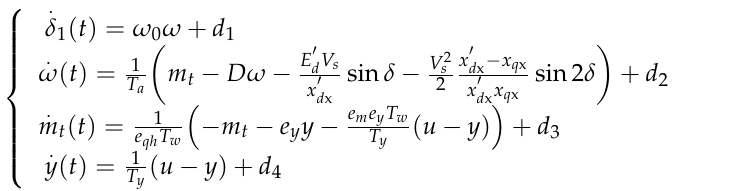
Figure 2. Lyapunov exponents of system (1). Using the same parameters as above, a bifurcation diagram of the system with the variation of 𝛿 1 (𝑡 0 ) is shown in Figure 3a, and the mean value of 𝛿 1 is given in Figure 3b. Here, 𝛿 1 (𝑡 0 ) varies from −5 00 to 500 with a step size of four. It is shown in Figure 3 that the value of variable δ1 increases with the increase of 𝛿 1 (𝑡 0 ) on the whole. The position of attractors is changed with the initial conditions. According to reference [32], this phe- nomenon satisfies the concept of offset boosting. Thus, multi-stability is found in the sys- tem.